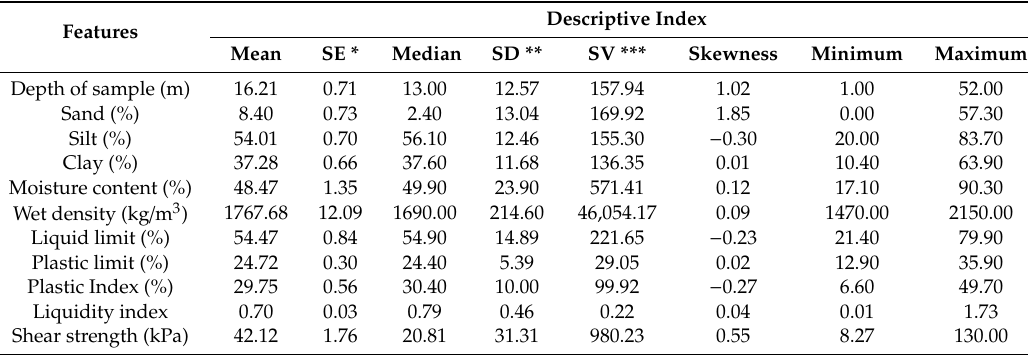
Table 1. Descriptive statistics of the used dataset.